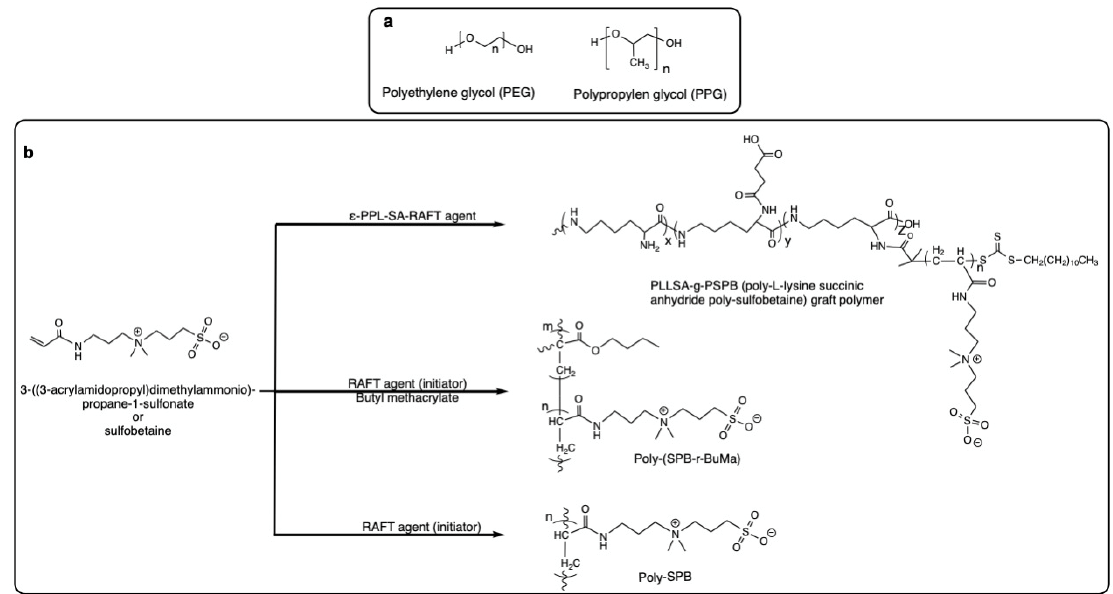
Figure 5. Chemical structures of synthetic amphiphilic polymers with potential to serve as PS alter- natives: ( a ) Polyether polyols, ( b ) Sulfobetaine and its derivatives as examples of polyampholates.